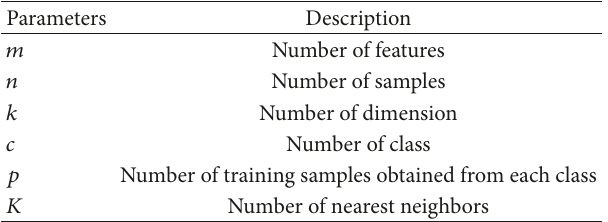
Table 2: Parameters